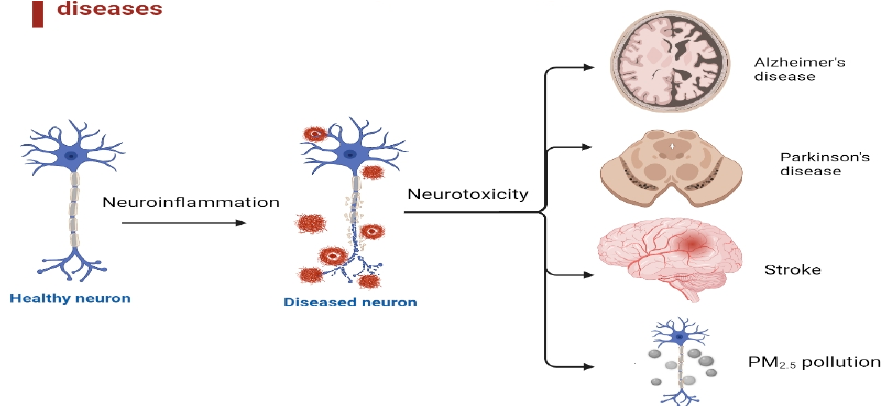
Figure 1. Neuroinflammation plays a crucial role in the pathological processes of AD, PD, stroke, and PM 2.5 pollution in the brain.